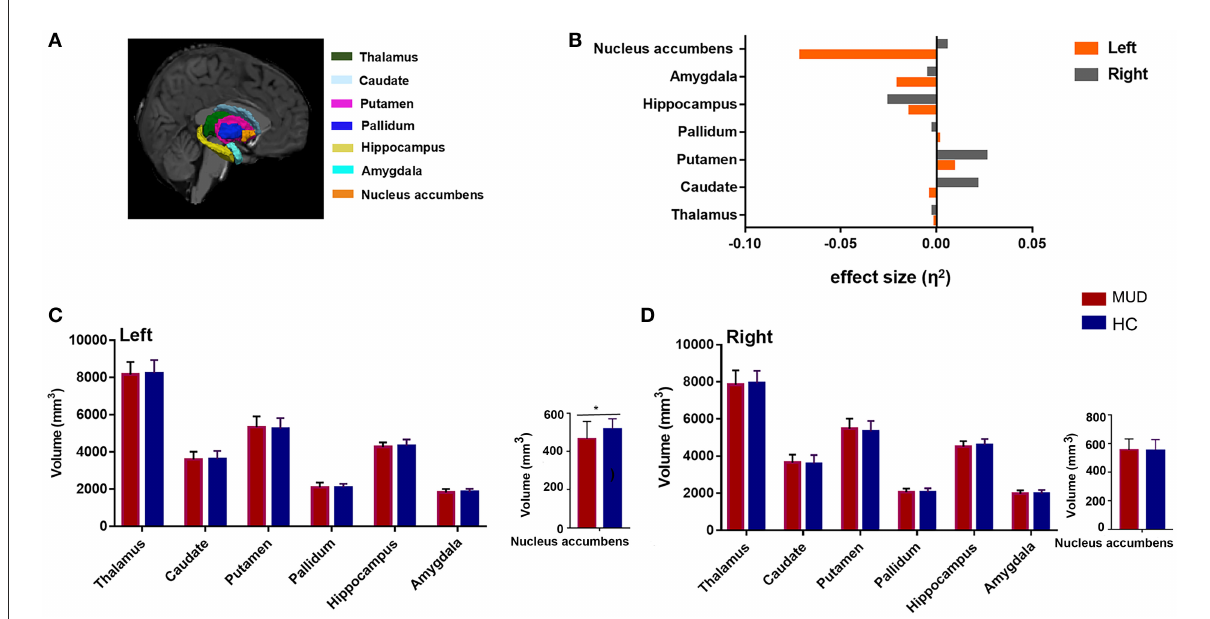
FIGURE2 (A) An example of subcortical nucleus segmentation by FreeSurfer (version 6.0) in a healthy subject (right subcortical nucleus is shown). (B) Effect sizes for differences in left (gray) and right (orange) subcortical nuclei between the MUDs and HCs. (C,D) Bar plots of volumes (mm 3 ) of the bilateral subcortical nucleus in the MUD participants and HCs after controlling for age, years of education and ICV. *Indicates significance after FDR correction. MUD, methamphetamine use disorder; HCs, healthy control; ICV, intracranial volume; FDR, false discovery rate; L, left; R, right.